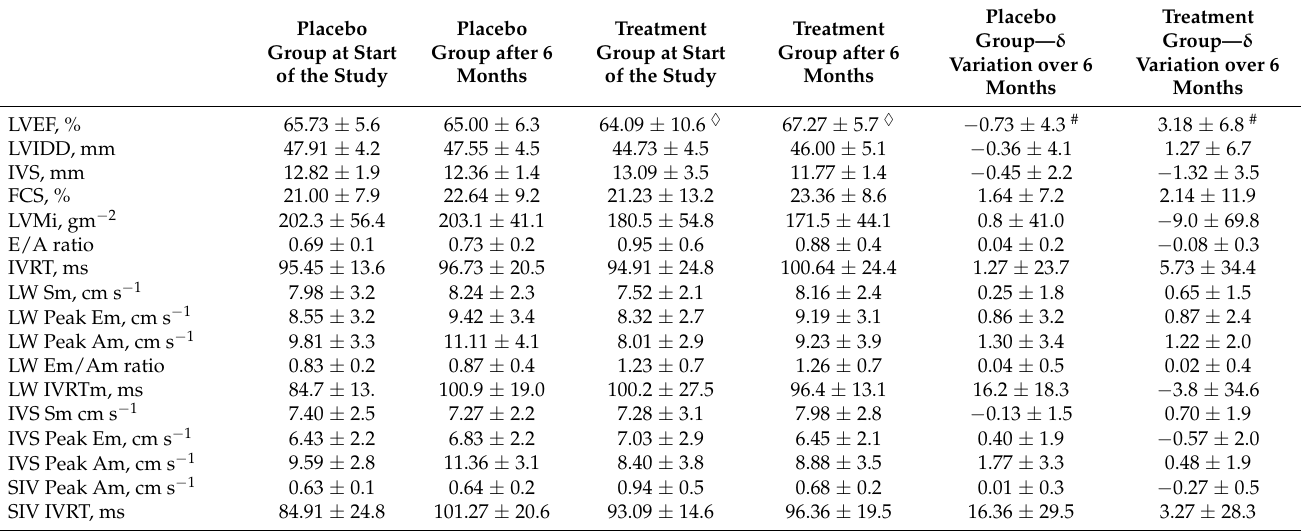
Table 5. Analysis of Interdialytic Echocardiographic Parameters Between Treatment and Placebo Groups and Differences in Temporal Inter-Study ( δ ) and Intra-Study Group